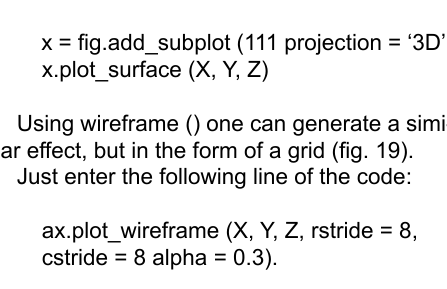
x = fig.add_subplot (111 projection = ‚3D’) ax.contour (X,Y,Z)